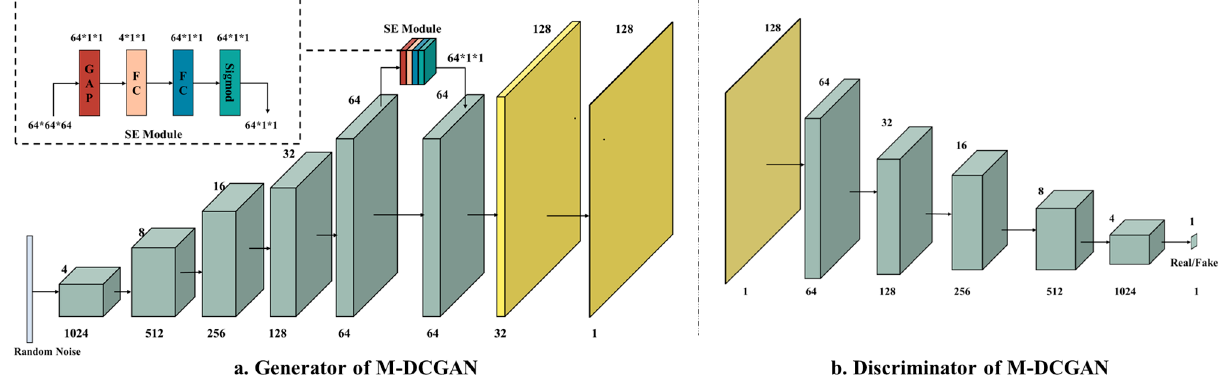
Figure 6. M-DCGAN architecture.